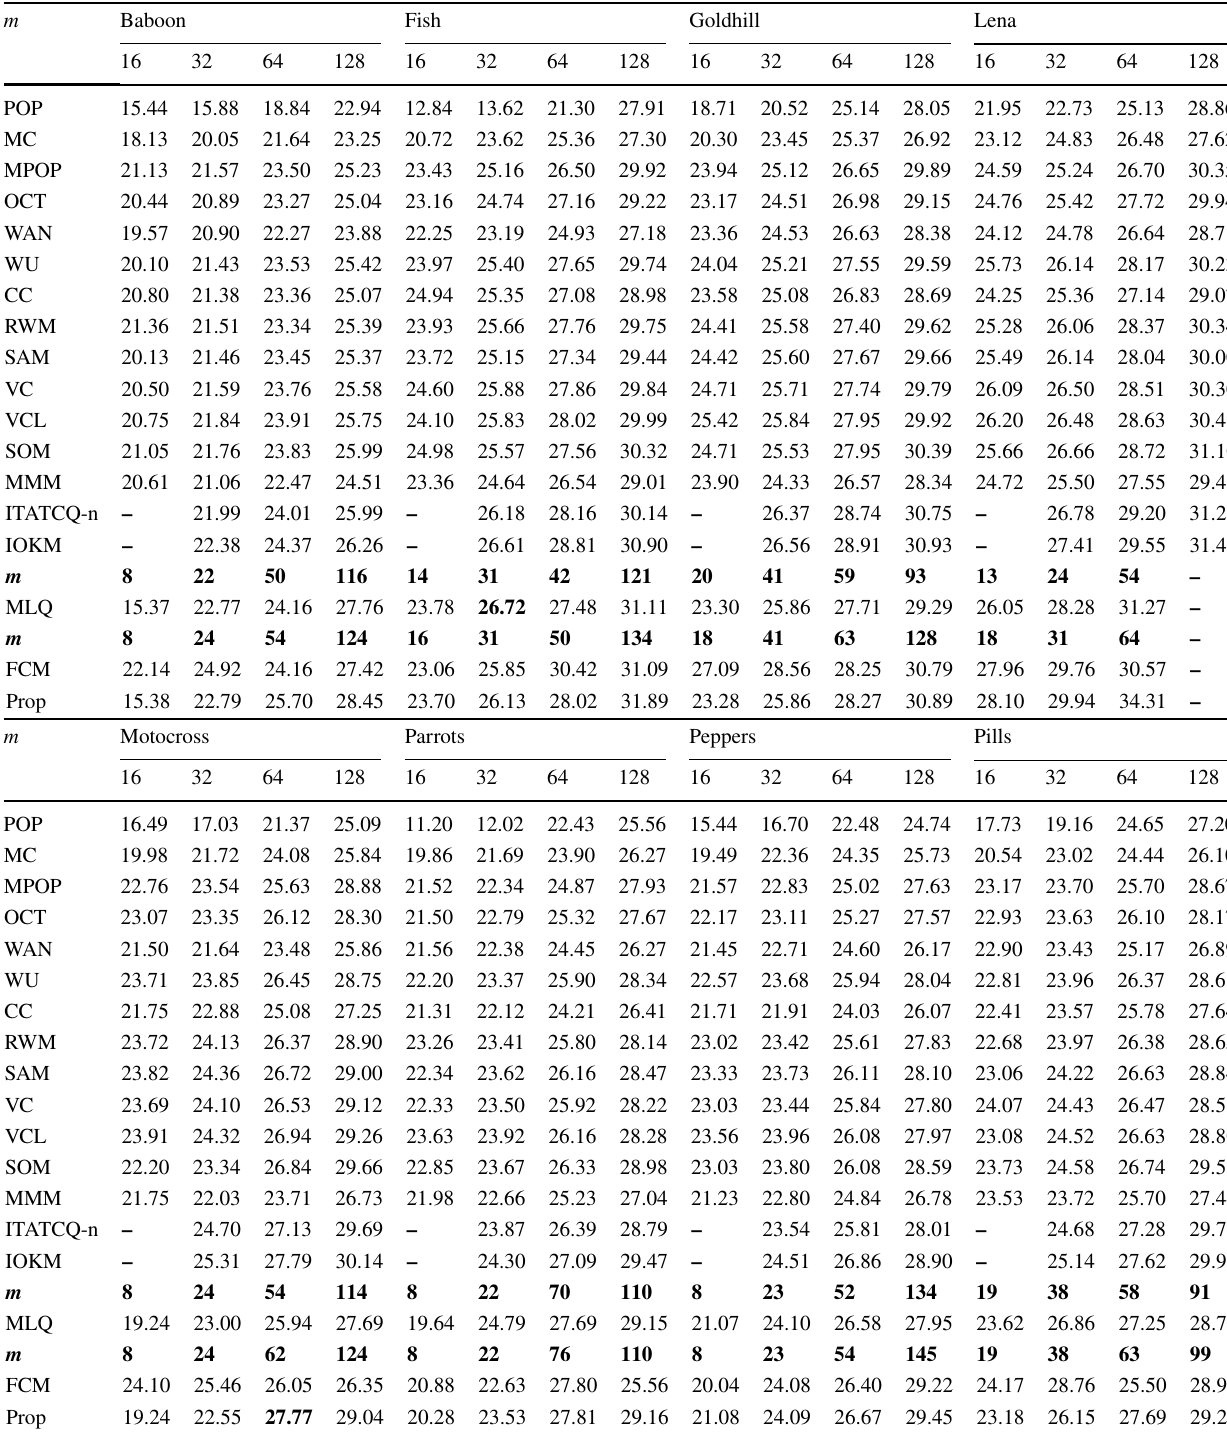
Table 8 PSNR results of quantization